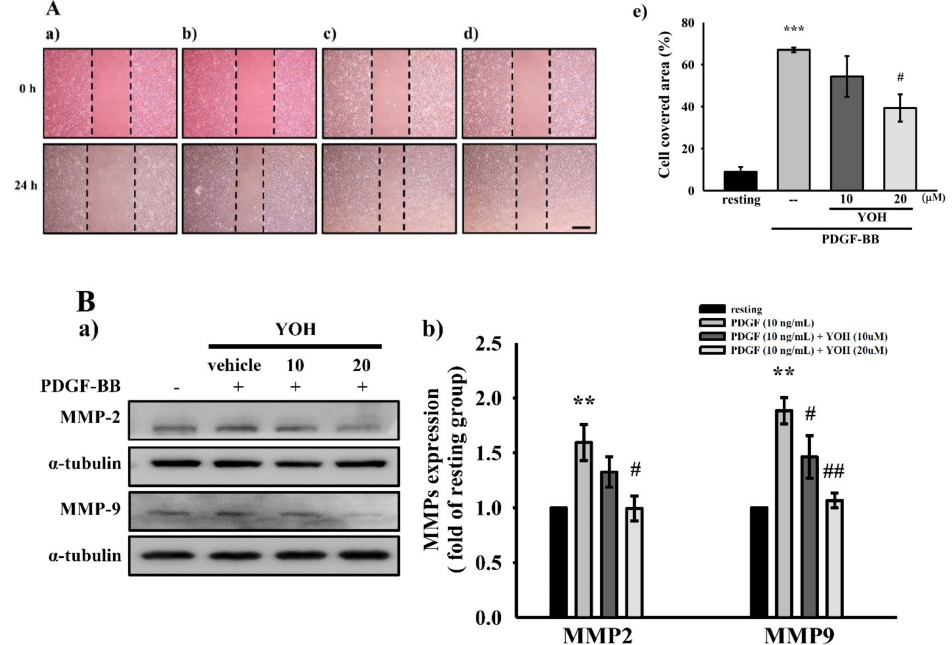
Figure 2. Effects of YOH on cell migration and MMP-2 and MMP-9 expression in PDGF-BB-stimulated MOVAS-1 cells. ( A ) MOVAS-1 cell monolayers were scratched and then preincubated without ( a ) or with 0.1% DMSO ( b ) or YOH (( c ) 10 or ( d ) 20 µ M) for 45 min and then treated with PDGF (10 ng/mL) for 24 h. The quantified wound closure area (%) is shown in ( e ). ( B ) ( a ) Protein expression levels of MMP-2 and MMP-9 were evaluated through Western blotting. ( b ) Complied statistical data are presented on the right. ** p < 0.01, *** p < 0.001 compared with the resting group; # p < 0.05, ## p < 0.01 compared with the positive group. Data are presented as the mean ± S.E.M. ( n =